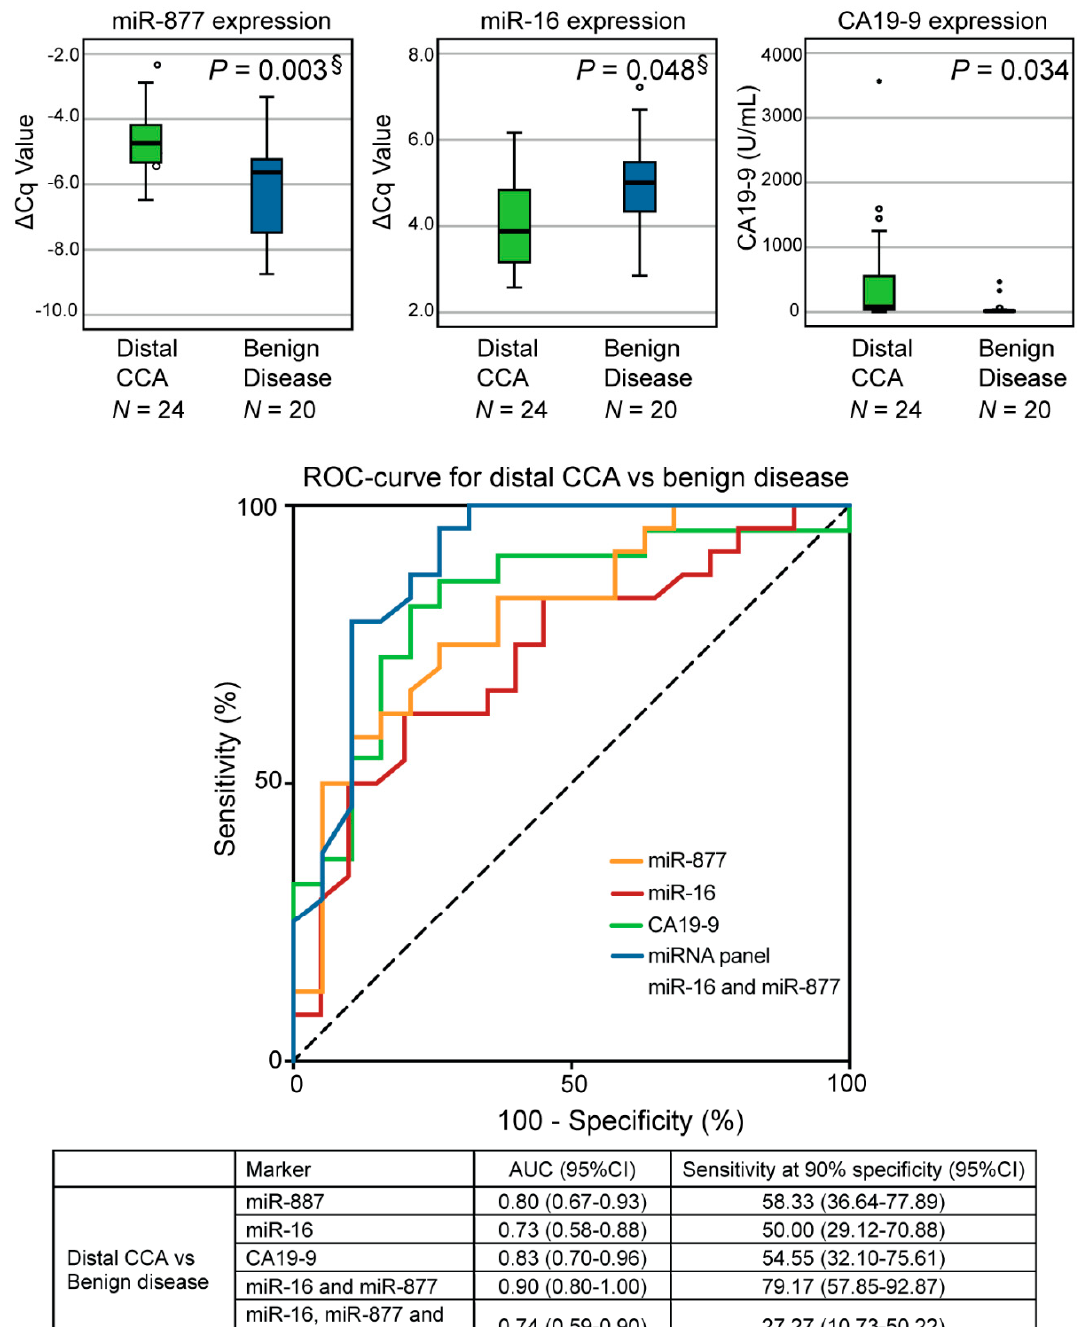
Figure 3. Validation of the selected miRNAs in the validation phase comparing distal CCA and benign disease. Upregulated miR-877, downregulated miR-16 and CA19–9 were significantly differentially expressed in distal CCA compared to benign disease. The two-miRNA panel comprising miR-877 and miR-16 was the most optimal combination (AUC of 0.90) to diagnose distal CCA compared to benign disease. Box plots are displayed for the average Δ Cq values, with the horizontal lines representing the mean ± SD. Δ Cq = Normalized Cq value, distal CCA = distal cholangiocarcinoma, miRNA = microRNA §Bonferroni-adjusted P -values are shown.